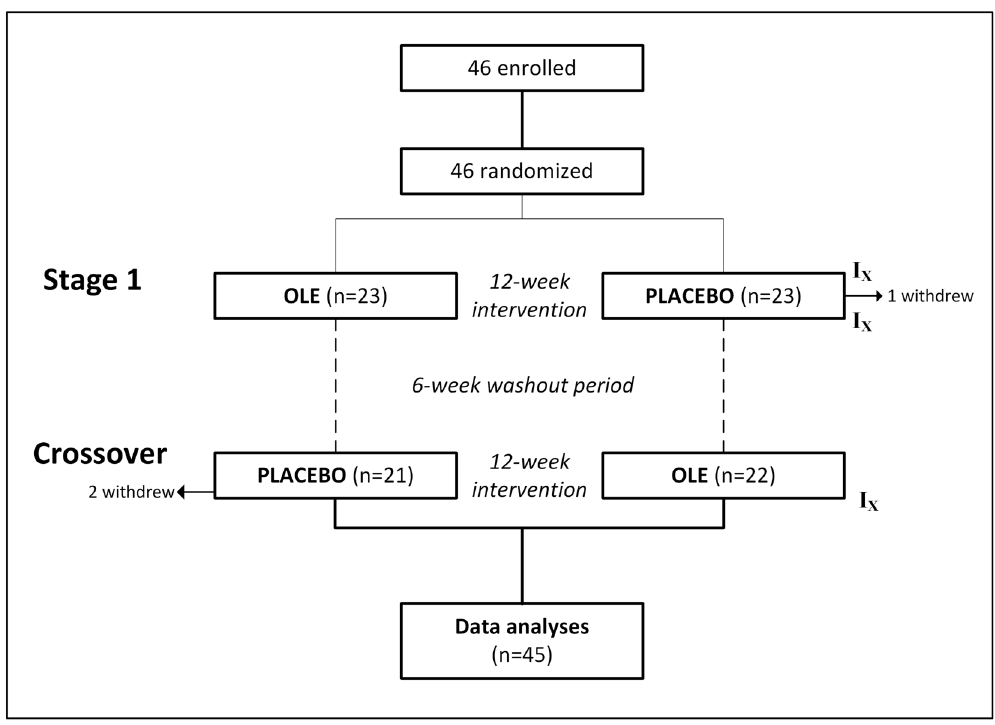
Figure 1. Summary of study’s recruitment process and trial execution. I X indicates timing of assessments. One participant withdrew from the study during stage 1 due to injury, while the two subjects that withdrew after crossover were either lost to follow up or to the developing acne. profiles after the glucose challenge were calculated and expressed as the area under the curve (AUC).